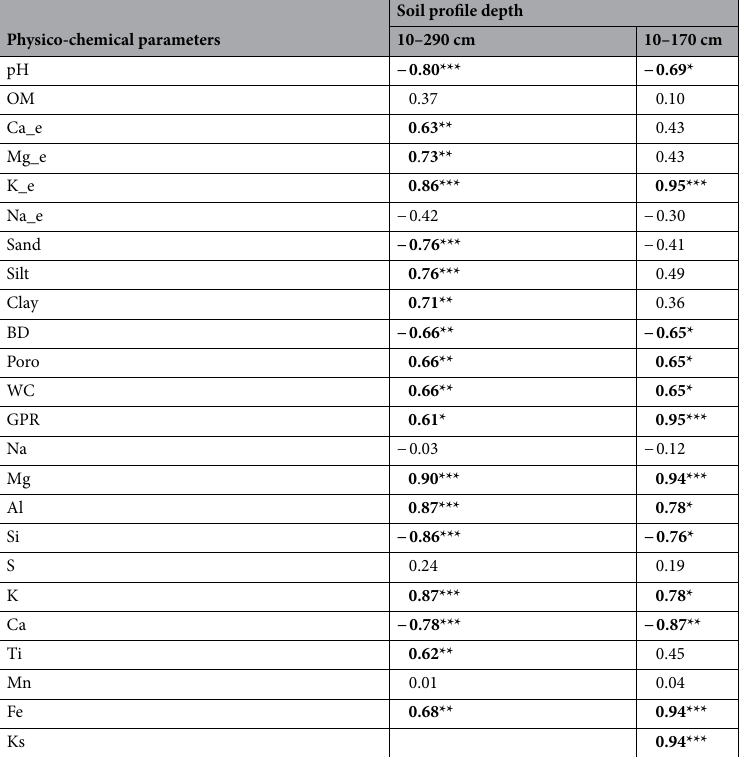
Table 1. Correlation (Spearman r coefficient) between the semi-quantitative colony forming unit (CFU) counts of B. pseudomallei (CFU g −1 ) and soil physico-chemical characteristics at the full soil profile depth (10–290 cm) and the maximum depth that the saturated hydraulic conductivity was measured (10–170 cm). Significance level: ***p < 0.001, **p < 0.01, *p < 0.05. Listed are pH; organic matter content (OM, %); exchangeable calcium (Ca_e, meq 100 g −1 ); exchangeable magnesium (Mg_e, meq 100 g −1 ); exchangeable potassium (K_e, meq 100 g −1 ); exchangeable sodium (Na_e, meq 100 g −1 ); silt, sand and clay textural fractions (%); bulk density (BD, g cm 3 ); soil porosity (poro, %); volumetric water content (WC, m 3 m −3 ); groundwater persistence rate (GPR, %); iron content (Fe, ppm); aluminum content (Al, ppm); manganese content (Mn, ppm); sulfur content (S, ppm); titanium content (Ti, ppm); potassium content (K, ppm); silicium content (Si, ppm); saturated hydraulic conductivity (Ks, mm h −1